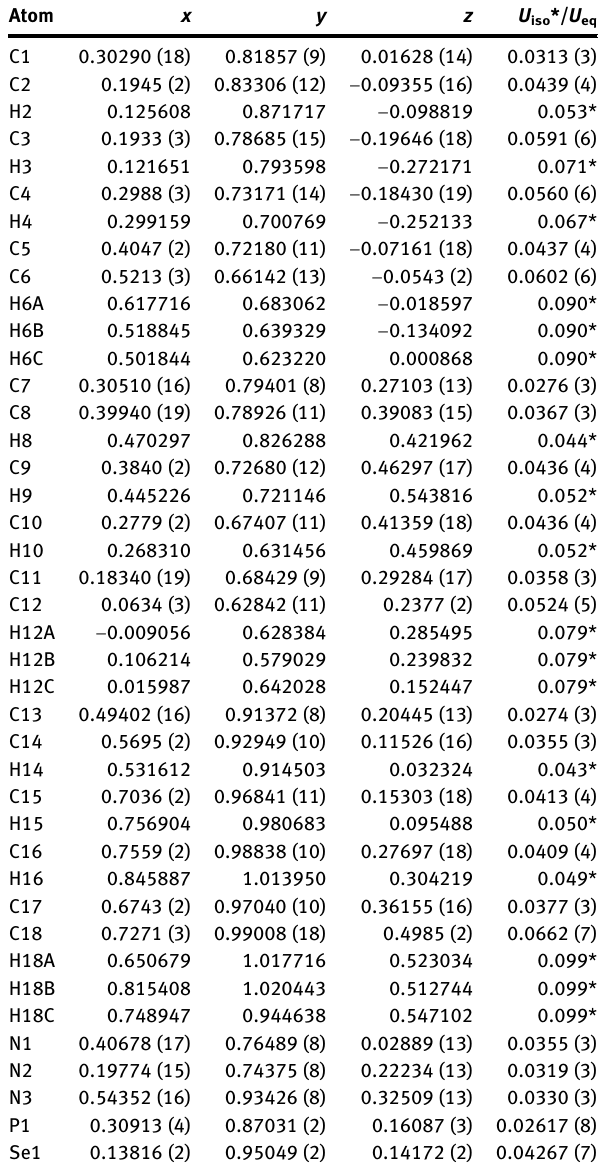
Table  : Fractional atomic coordinates and isotropic or equivalent isotropic displacement parameters (Å 